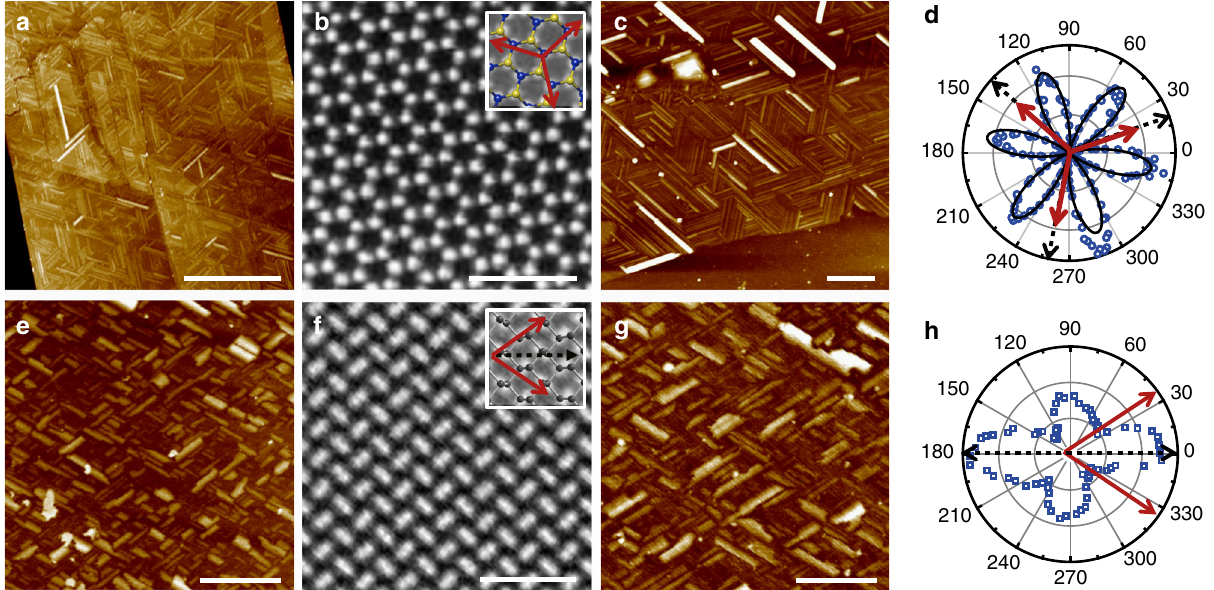
Fig. 2 Correlations between the orientations of oleamide nanoribbons and the lattice of underlying 2D materials. a , b AFM image and Fourier fi ltered STEM image of the same few-layer MoS 2 fl ake with oleamide nanoribbons. Inset Schematic representation of top view of MoS 2 atomic structures. Red arrows correspond to the orientations of nanoribbons on this fl ake. c , d AFM image and polarization angle-dependent SHG intensity plot of the same monolayer MoS 2 fl ake with oleamide nanoribbons. The black dashed arrows indicate the zigzag directions of this MoS 2 fl akes determined by SHG and the red arrows correspond to the orientations of nanoribbons on this fl ake. e , f AFM image and Fourier fi ltered STEM image of the same multilayer black phosphorus fl ake with oleamide nanoribbons. Inset Schematic representation of top view of the atomic structure of black phosphorus. Red arrows correspond to the orientations of nanoribbons. The black dashed arrow indicates the armchair direction of this fl ake. g , h AFM image and angle-dependent polarized Raman intensity plot of the same multilayer black phosphorus fl ake with oleamide nanoribbons. The black dashed arrow indicates the armchair direction of this fl ake determined by Raman measurements and the red arrows indicate the orientations of the nanoribbons on this fl ake. Scale bars for a , c , e and g are 500 nm and for b , f are 1 with tetragonal symmetry and ReS 2 with triclinic symmetry (Fig. 2e and Supplementary Fig. 10c) with atomically resolved STEM and angle-resolved polarized Raman spectroscopy.